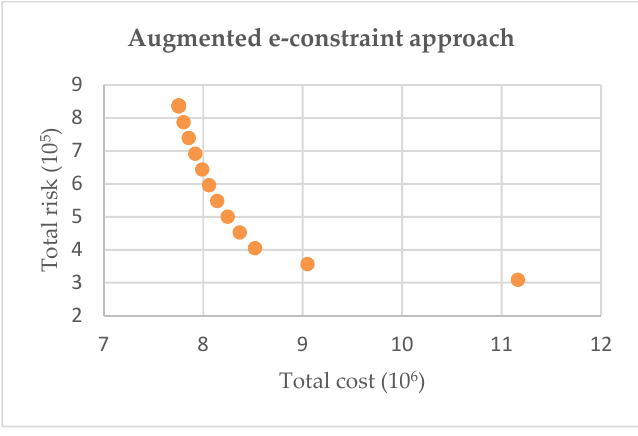
Figure 8. Solutions in augmented ε -constrained approach.